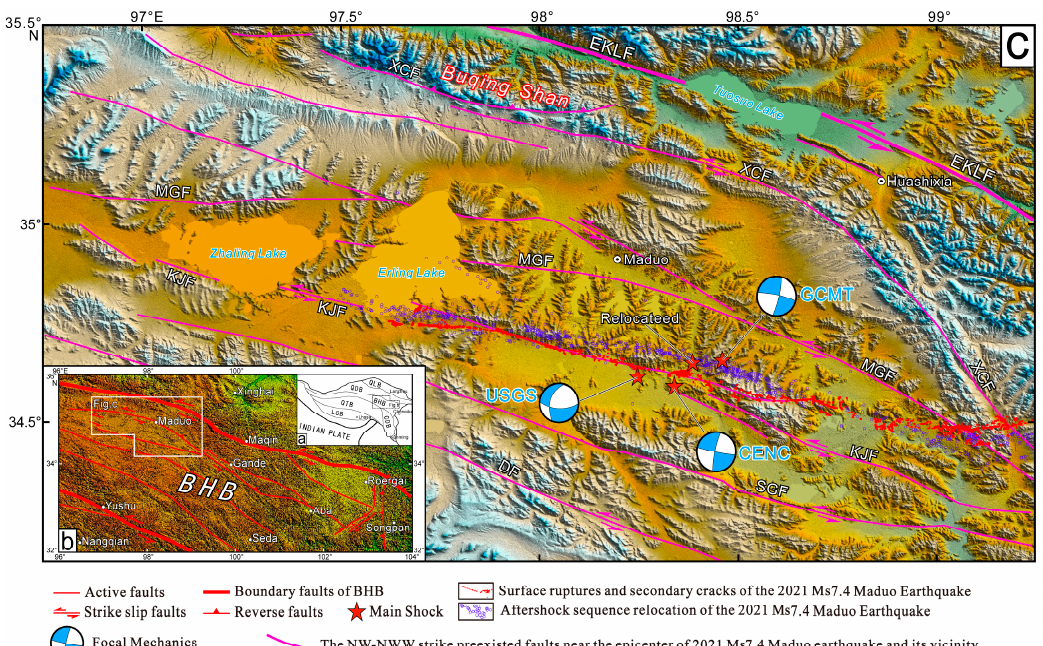
surface rupture and the fault kinematics characteristics.